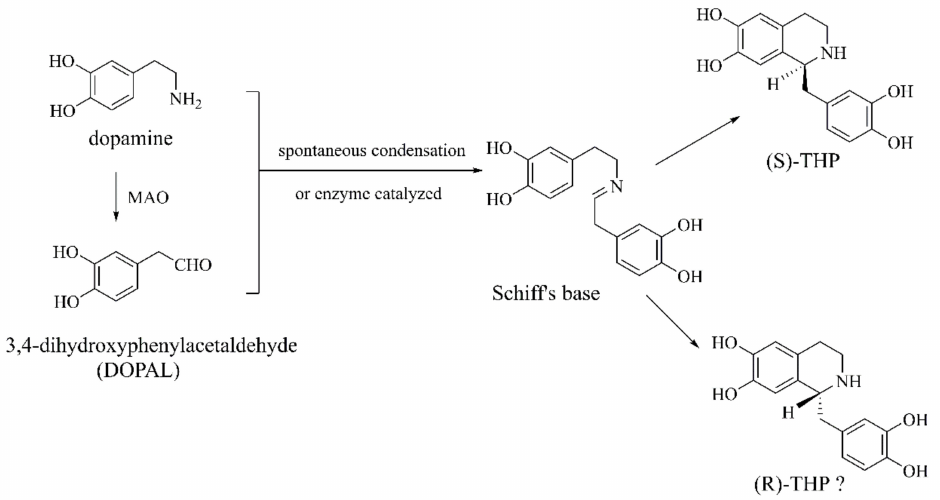
Figure 5. The biosynthesis of tetrahydropapaveroline (THP) (?-unknown) [52,54]. ADTIQ